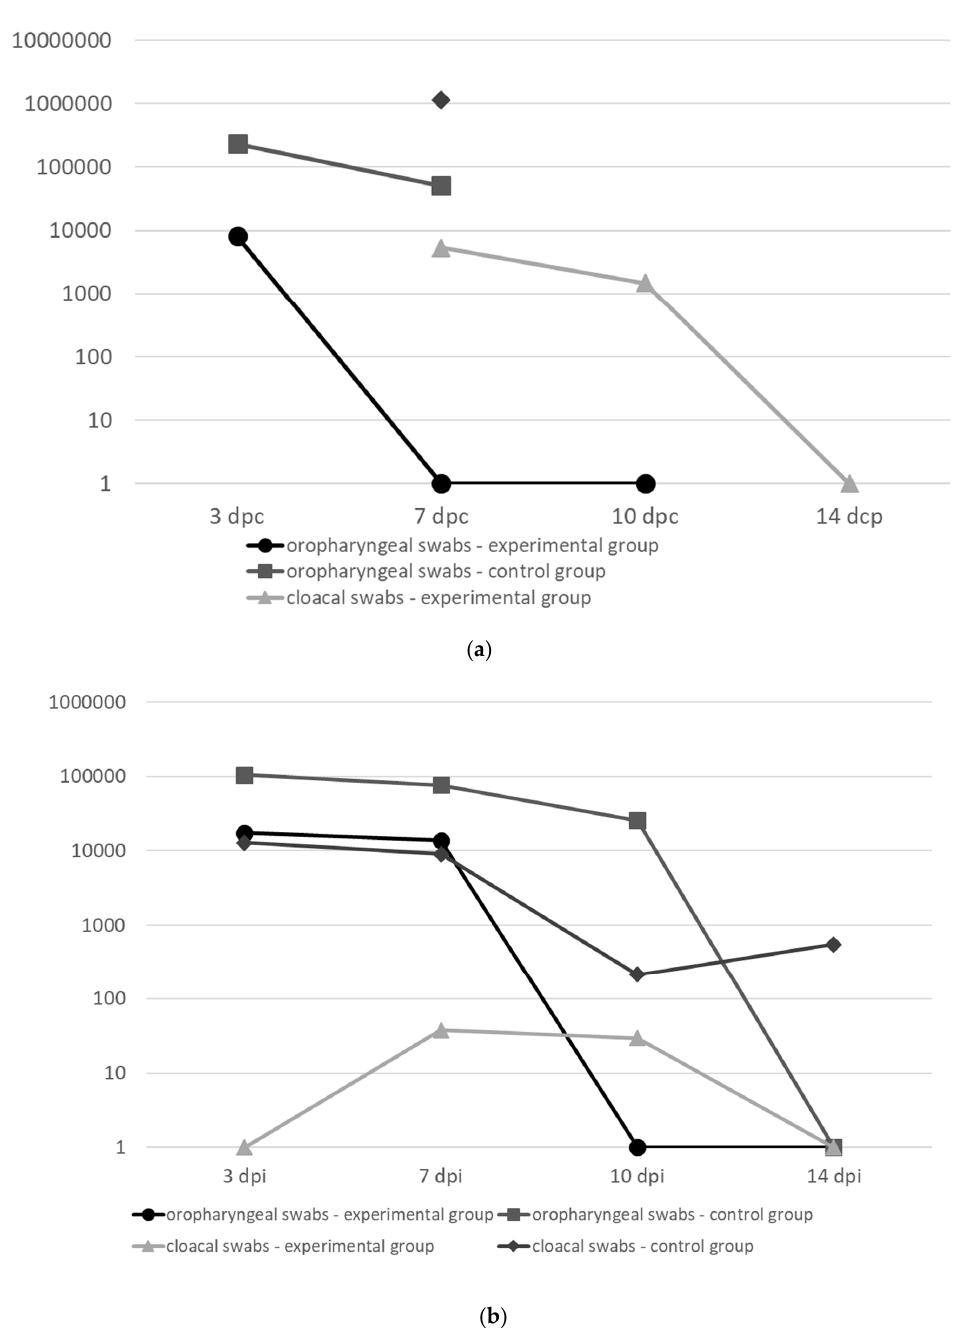
Figure 1. Median values of shedding of the challenge AAvV-1 virus of genotype IV ( a ) and genotype VII ( b ) in oropharyngeal and cloacal swabs of broiler chickens immunized with the HVT-NDV-F-HN construct at 1 day of age and challenged 6 weeks later expressed as eqEID 50 .